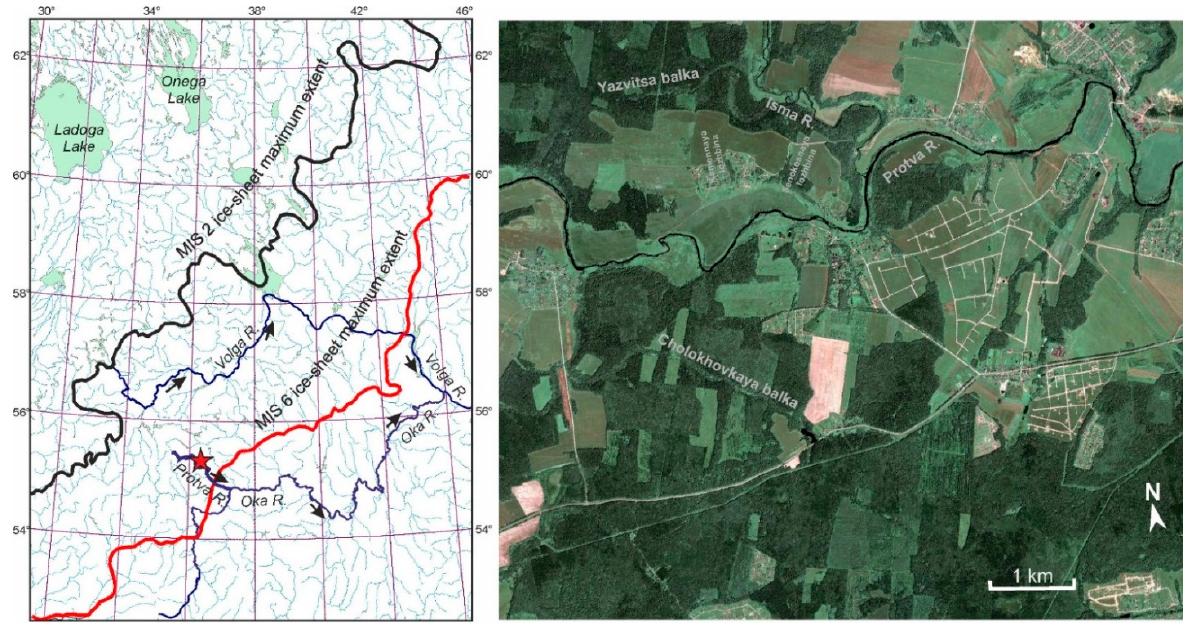
Figure 1. On the left: southeastern boundaries of MIS 6 (Moscovian) icesheet (red line) and MIS 2 (Late Valdaian) icesheet (black line) on the East European Plain (adapted from [9]). The asterisk indicates the position of the key area. On the right is an image of the key area from Google Earth.